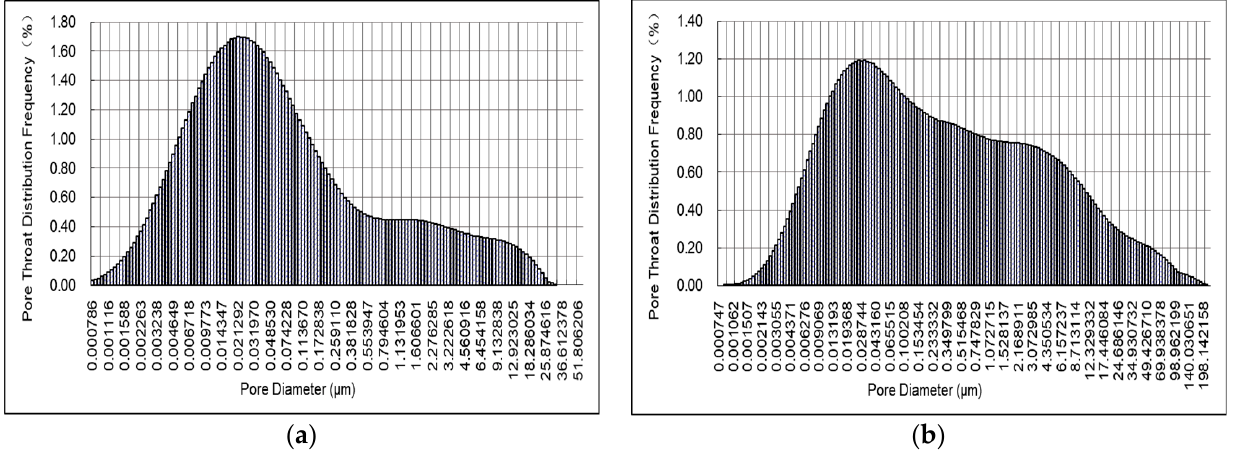
Figure 4. Distribution of core pore size (No. 3 of Well XX2-2-3): ( a ) before fracture; ( b ) After fracture.